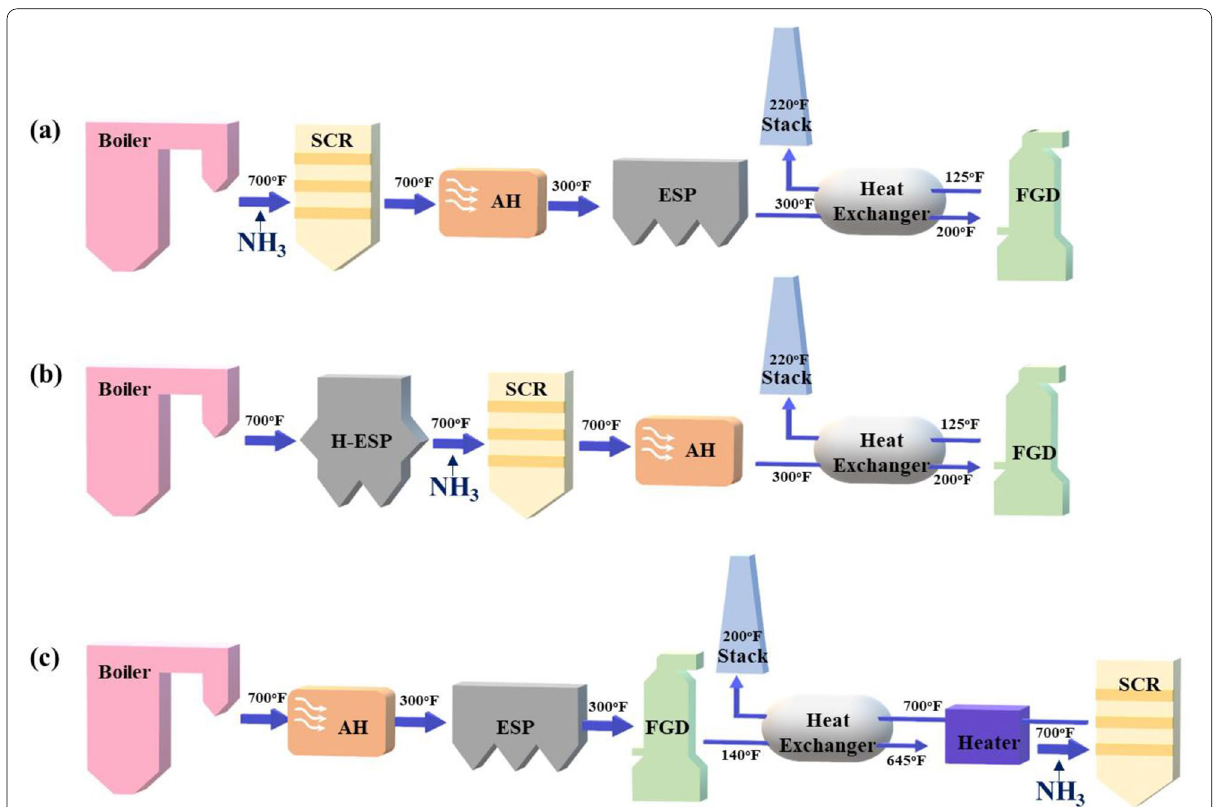
Fig. 2 SCR configurations with typical system temperatures: a high‑dust system, b low‑dust system, and c tail‑end system